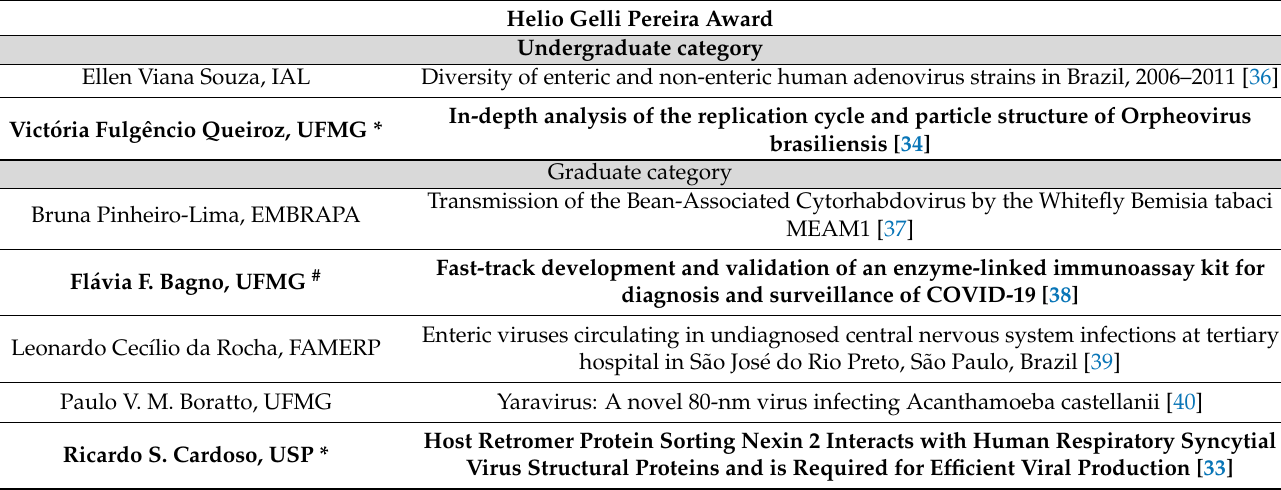
Table 3. Oral presentations on the HGP